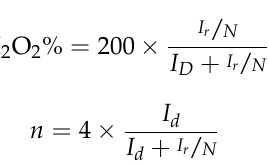
Figure S2: The elemental mapping of the Fe-PC@NaCl catalyst; Figure S3: (a) CV curves of Fe-